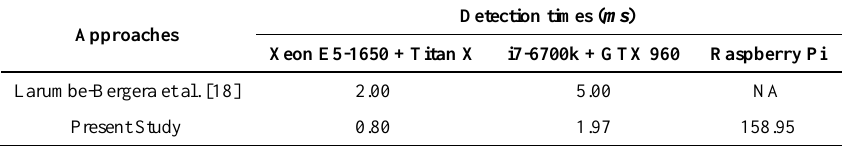
Table 5. Comparison of the average detection time between the winner detector and the state-of-the-art one